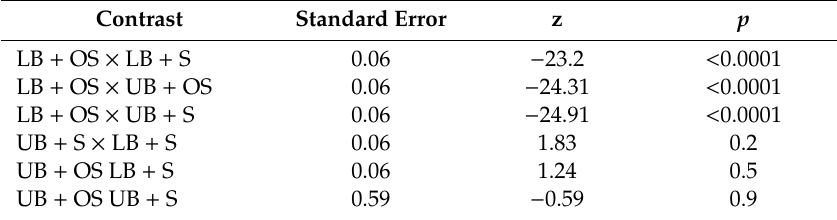
Table 2. Linear mixed models (LMM) and post-hoc Tukey test for